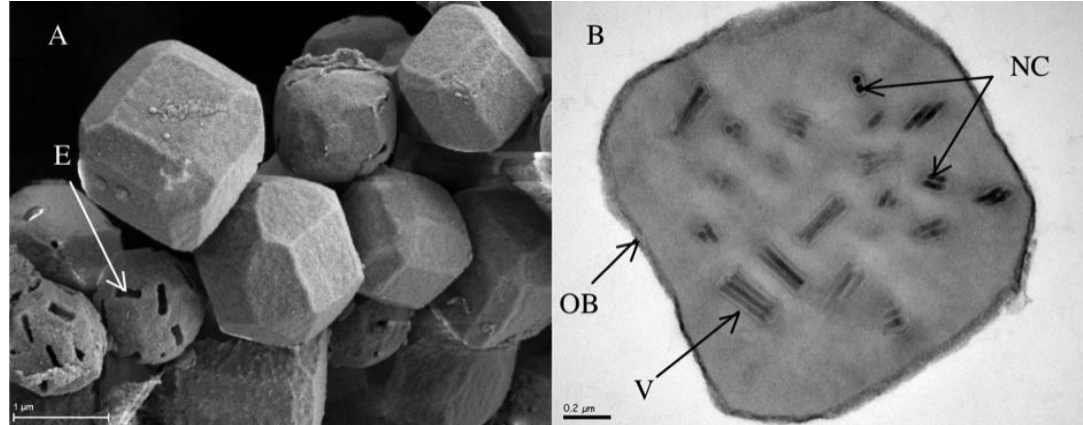
Figure 1. Autographa californica multiple nucleopolyhedrovirus (AcMNPV) occlusion bodies. ( A ) Scanning electron microscopy (×20,000) showing several occlusion body (OB) shapes. The silhouette of virions is visible on emptied OBs (E); ( B ) Transmission electron microscopy (×50,000) showing the cross section of one OB with rod shape virions (V) and nucleocapsids (NC).